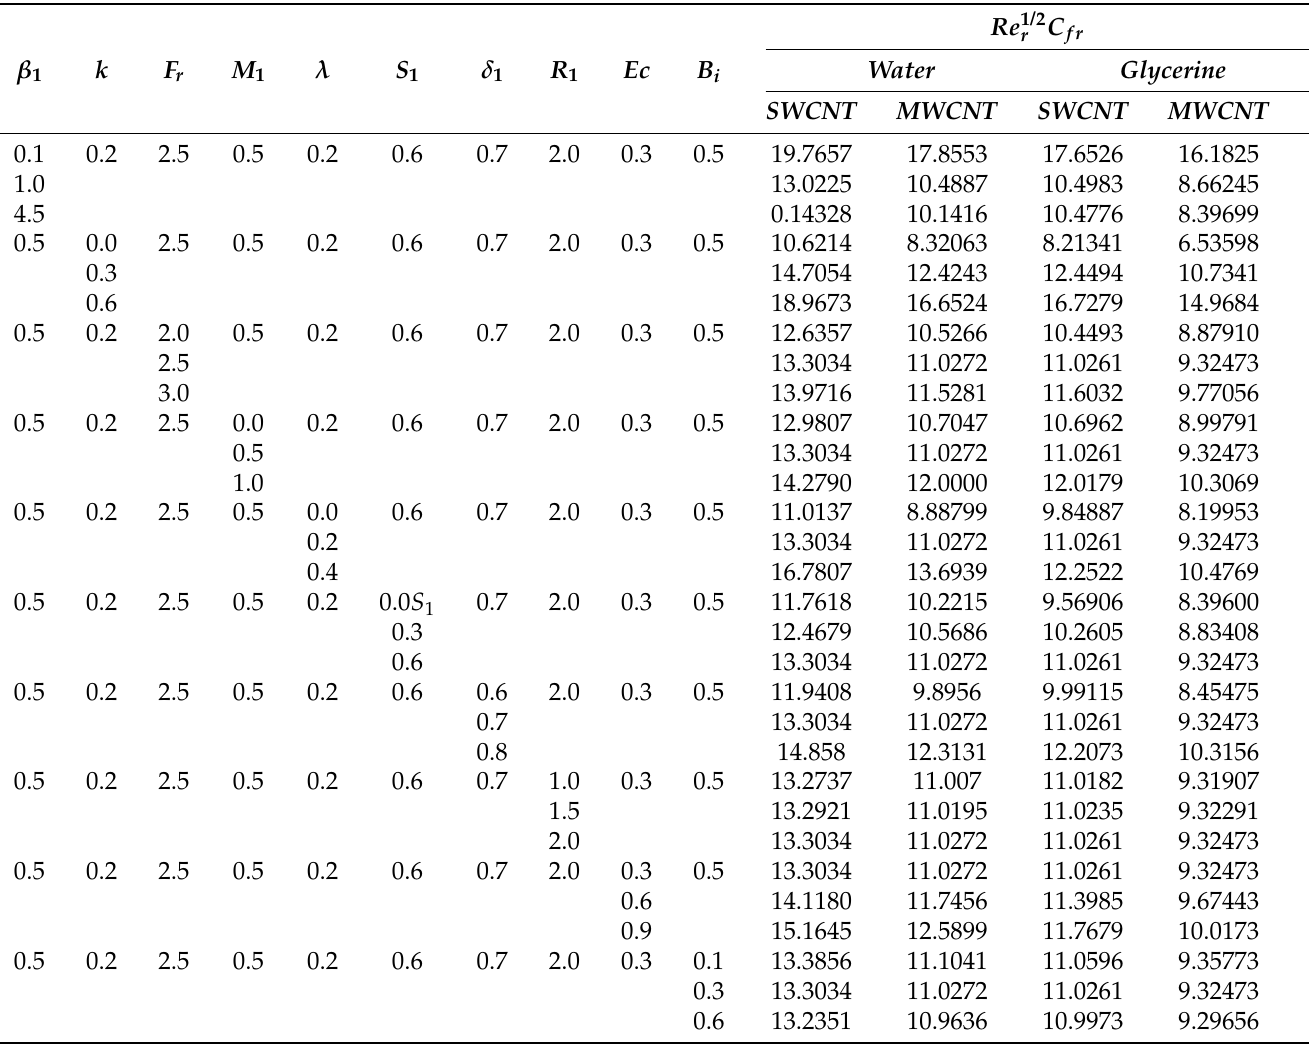
Figure 32. Impact of B i on Nusselt number. Table 2. Skin friction for water and Glycerine θ f =